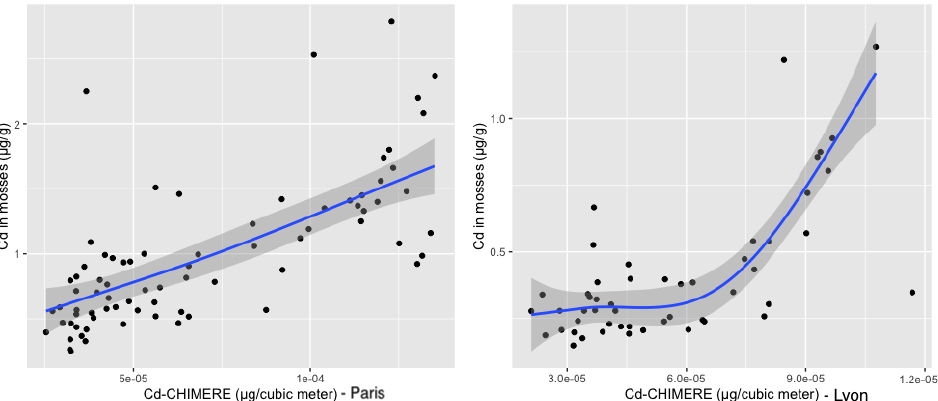
Figure 6. Link between Cd in mosses and the average CHIMERE Cd of the closest neighbors, for Île-de-France and the Lyon